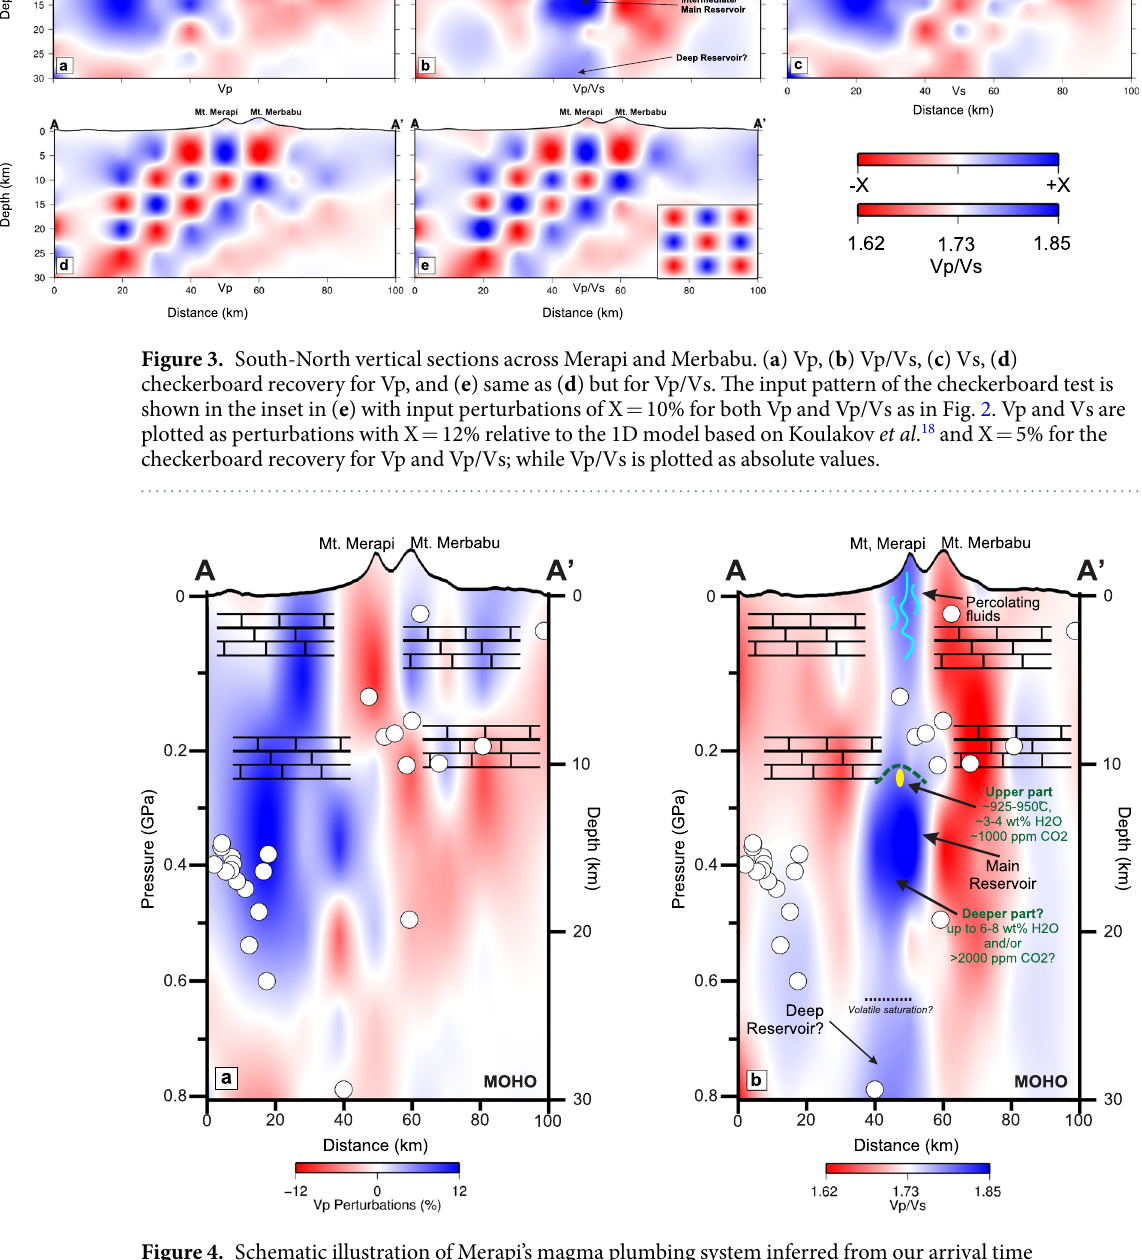
Figure 4. Schematic illustration of Merapi’s magma plumbing system inferred from our arrival time tomography analysis and published petrological data. ( a ) Vp and ( b ) Vp/Vs taken from Fig. 3a,b, respectively, with vertical exaggeration by a factor of 5 to emphasize vertical features. The tomogram in ( b ) shows an extensive high-Vp/Vs structure that extends from Merapi’s summit to the uppermost mantle with three main (shallow, intermediate, deep) anomalies at < 4 km, at ~10–20 km, and at > 25 km depth. We interpret the shallow anomaly as a fluid-rich zone, while we interpret the intermediate and deep anomalies to outline magma storage zones. We posit that the 2010 magma was sourced from the top of the intermediate reservoir (below the dashed line) at a depth just below 10 km and thus below the carbonate-dominated upper crust, with a volume of ≥ 1 km 3 (corresponding to the yellow ellipse). This estimate further constrains previous estimates based on phase- equilibrium experiments 6 . Magma in this zone has a temperature of ~925–950 °C, ~3–4 wt% H 2 O, and ~1000 ppm melt CO 25,6 , while magma deeper in the system may be significantly more volatile-rich and hazardous in case of ascent and eruption. We have assumed an average crustal density of 2242 kg/cm 3 (cf. 15 ) for the upper 10 km of the section, while we have estimated an average crustal density of 2900 kg/cm 3 for the crust below (cf. 33 , for intermediate-mafic crust). Open dots depict relocated hypocenters of earthquakes recorded during the DOMERAPI experiment projected from a distance up to 20 km on both sides of the vertical